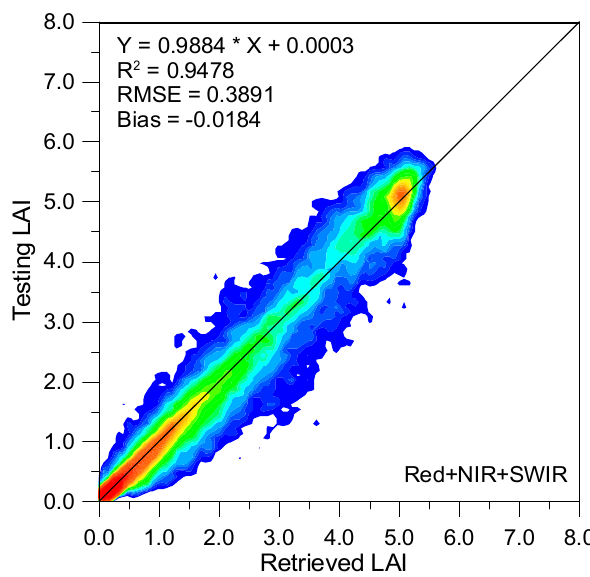
Figure 1. Comparison between the testing GLASS LAI values and the LAI values retrieved from VIIRS surface reflectance in the red, NIR and SWIR bands using the GRNNs. The size of the testing samples is 1758.